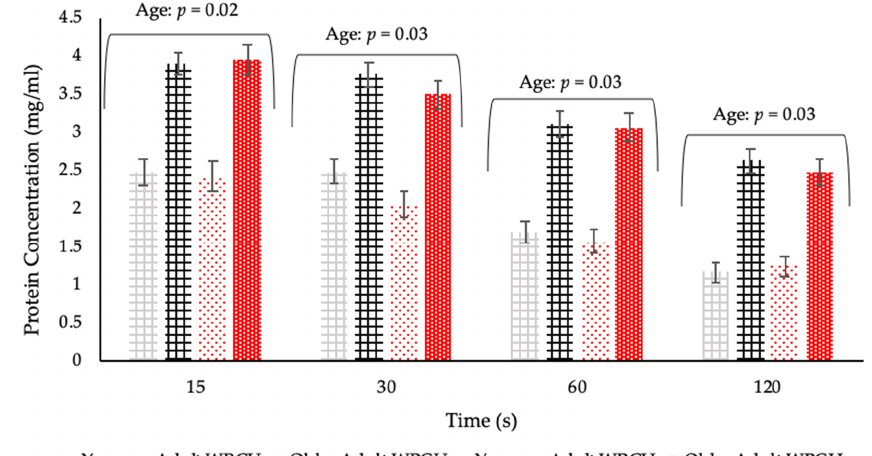
Figure 6. Protein concentration in saliva samples post whey protein beverage (WPB) consumption by